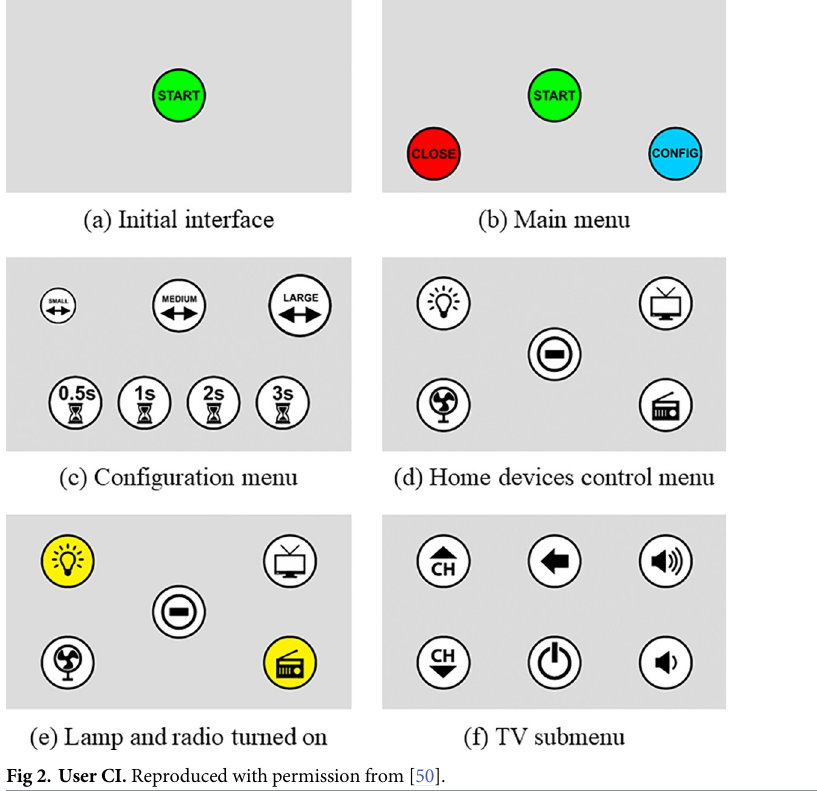
tion operating system, 4GB RAM, 500 GB HD memory, and 14” LED screen. 2. Tobii Eye Tracker 4C [61], which allows: a) booting with the computer, b) controlling with only one or both eyes, c) making movements with the head, maintaining the calibration. 3. Gaze Point software [62]: to control the mouse cursor using Tobii Eye Tracker 4C. 4. Global Box (gBox) (Fig 1): an SE controller module [50] that receives commands from the computer, via Wi-Fi, to activate home devices. 5. SE Control Interface (CI) (Fig 2) [50]: configured in a Web